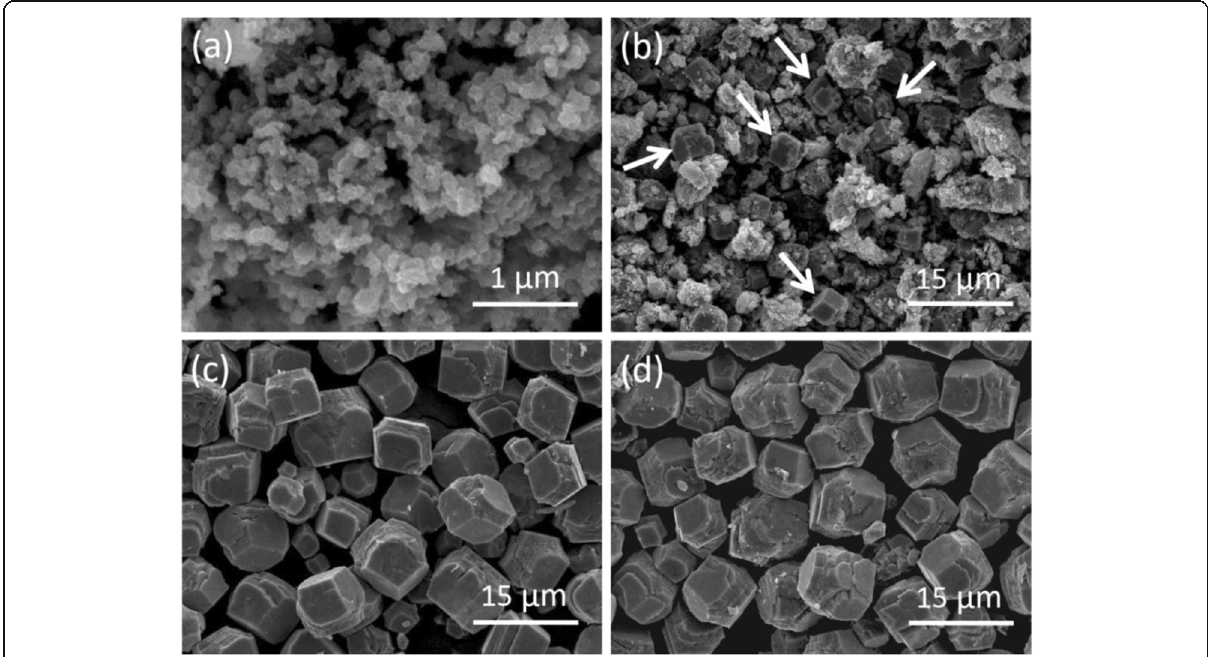
Fig. 4 SEM images of the Co 3 O 4 samples synthesized with different hydrothermal durations: a 1, b 2, c 15, and d 24